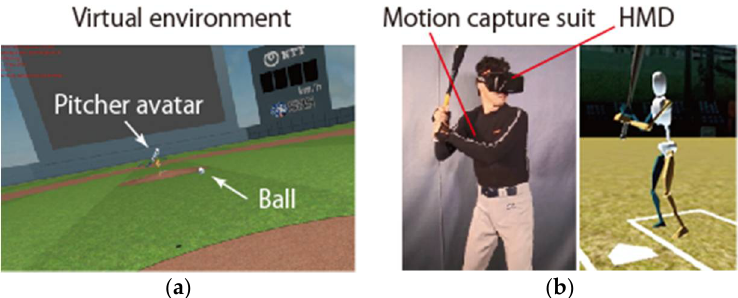
Figure 1. ( a ) Right batter’s view of virtual baseball environment; ( b ) VR system settings and a virtual avatar described in real